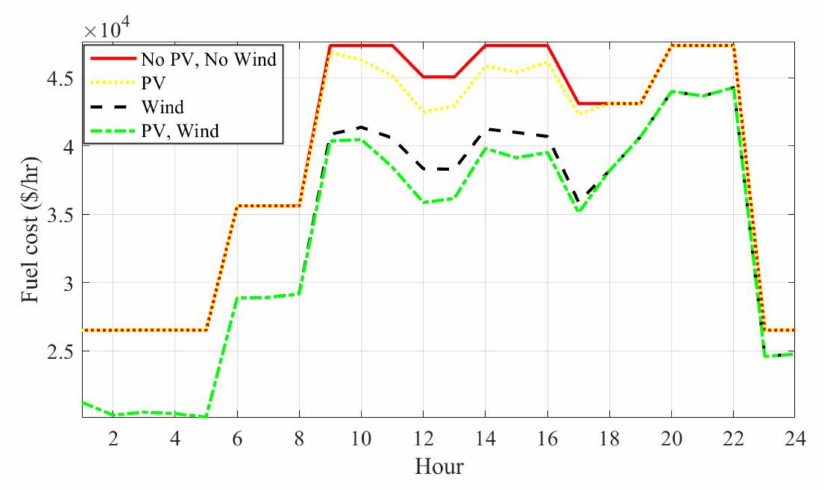
Figure 14. Hourly fuel cost in the case of the 57-bus system.